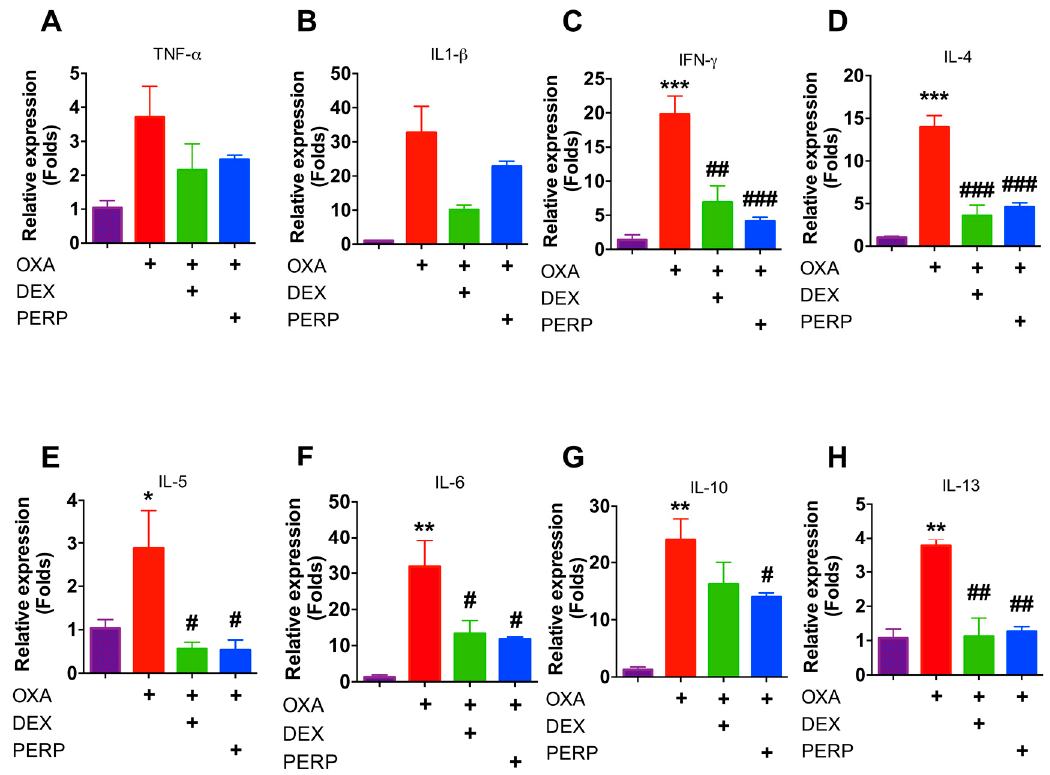
Figure 5. Perphenazine reduces the expression levels of cytokine in the lesion of OXA-induced dermatitis in mice mRNA expression of ( A ) TNF- α ( B ) IL-1 β ( C ) IFN- χ ( D ) IL-4 ( E ) IL-5 ( F ) IL-6 ( G ) IL-10 ( H ) IL-13 were determined from indicated mice ear. Data are presented as mean ± SEM and analyzed by one-way ANOVA (* p < 0.05, ** p < 0.01, *** p < 0.005 vs. control) and (# p < 0.05, ## p < 0.01, ### p < 0.005 vs. oxazolone treated).